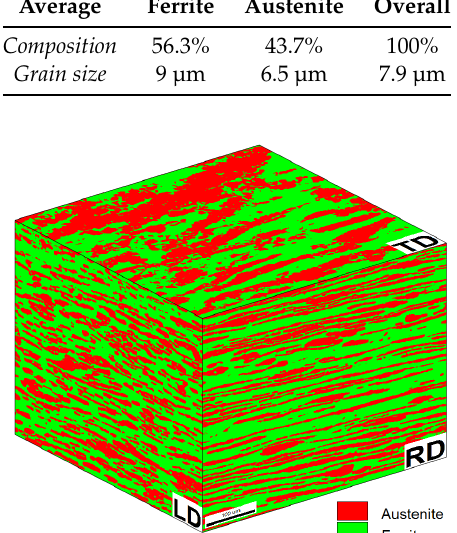
Figure 1. An illustration of the microstructure with the phases illustrated. The dimensions of the cube are 500 µm × 500 µm × 500 µm, green representing ferrite and red representing austenite. In the bottom right corner of each side, the plane normal is given. LD, RD, and TD are illustrated in Figure 2a.